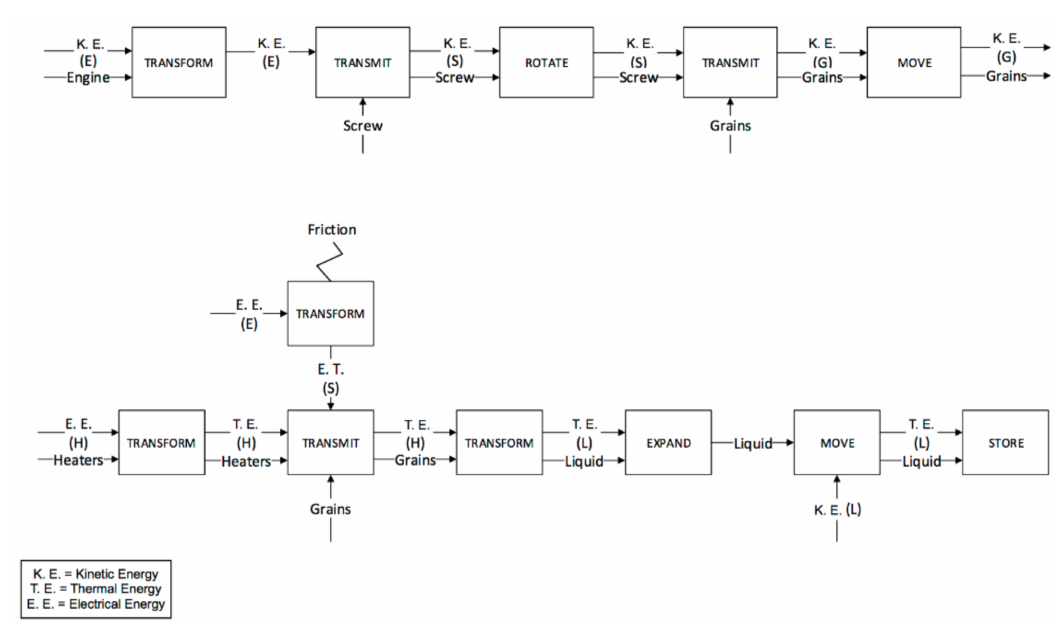
Figure 8. Plastication phase for the µ IM